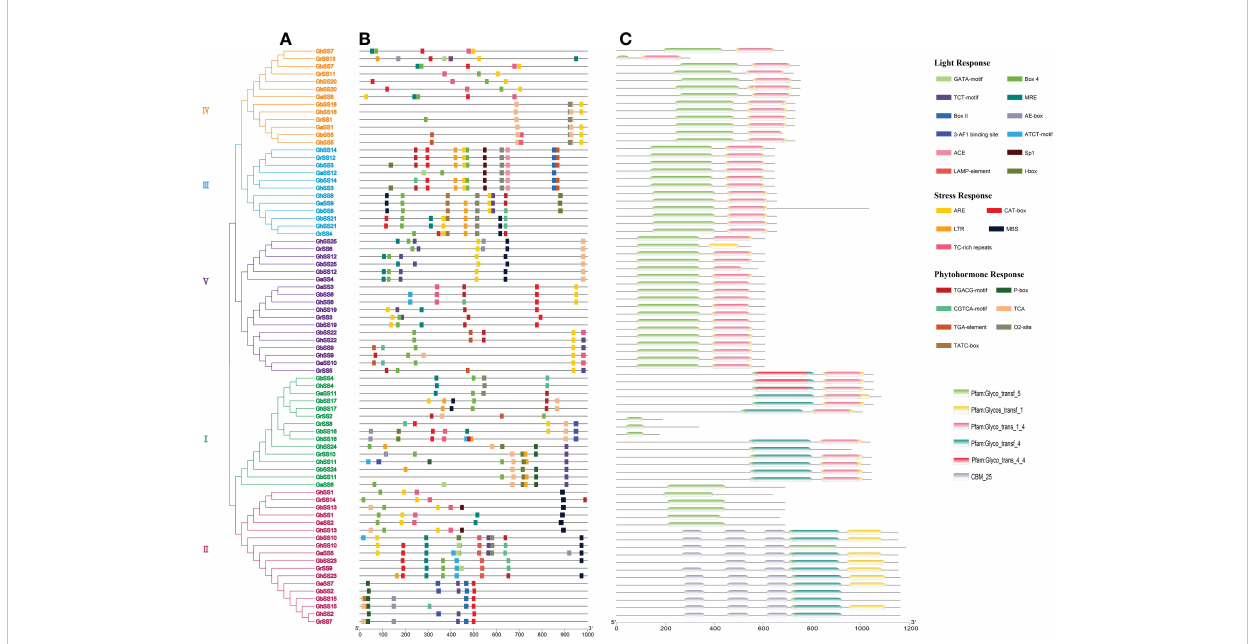
FIGURE 6 Promoters and conservative domains of SS genes in G arboreum , G raimondii , G hirsutum , and G barbadense . (A) Phylogenetic tree of SS genes. (B) Promoters of SS proteins. (C) The conservative domain of SS genes.